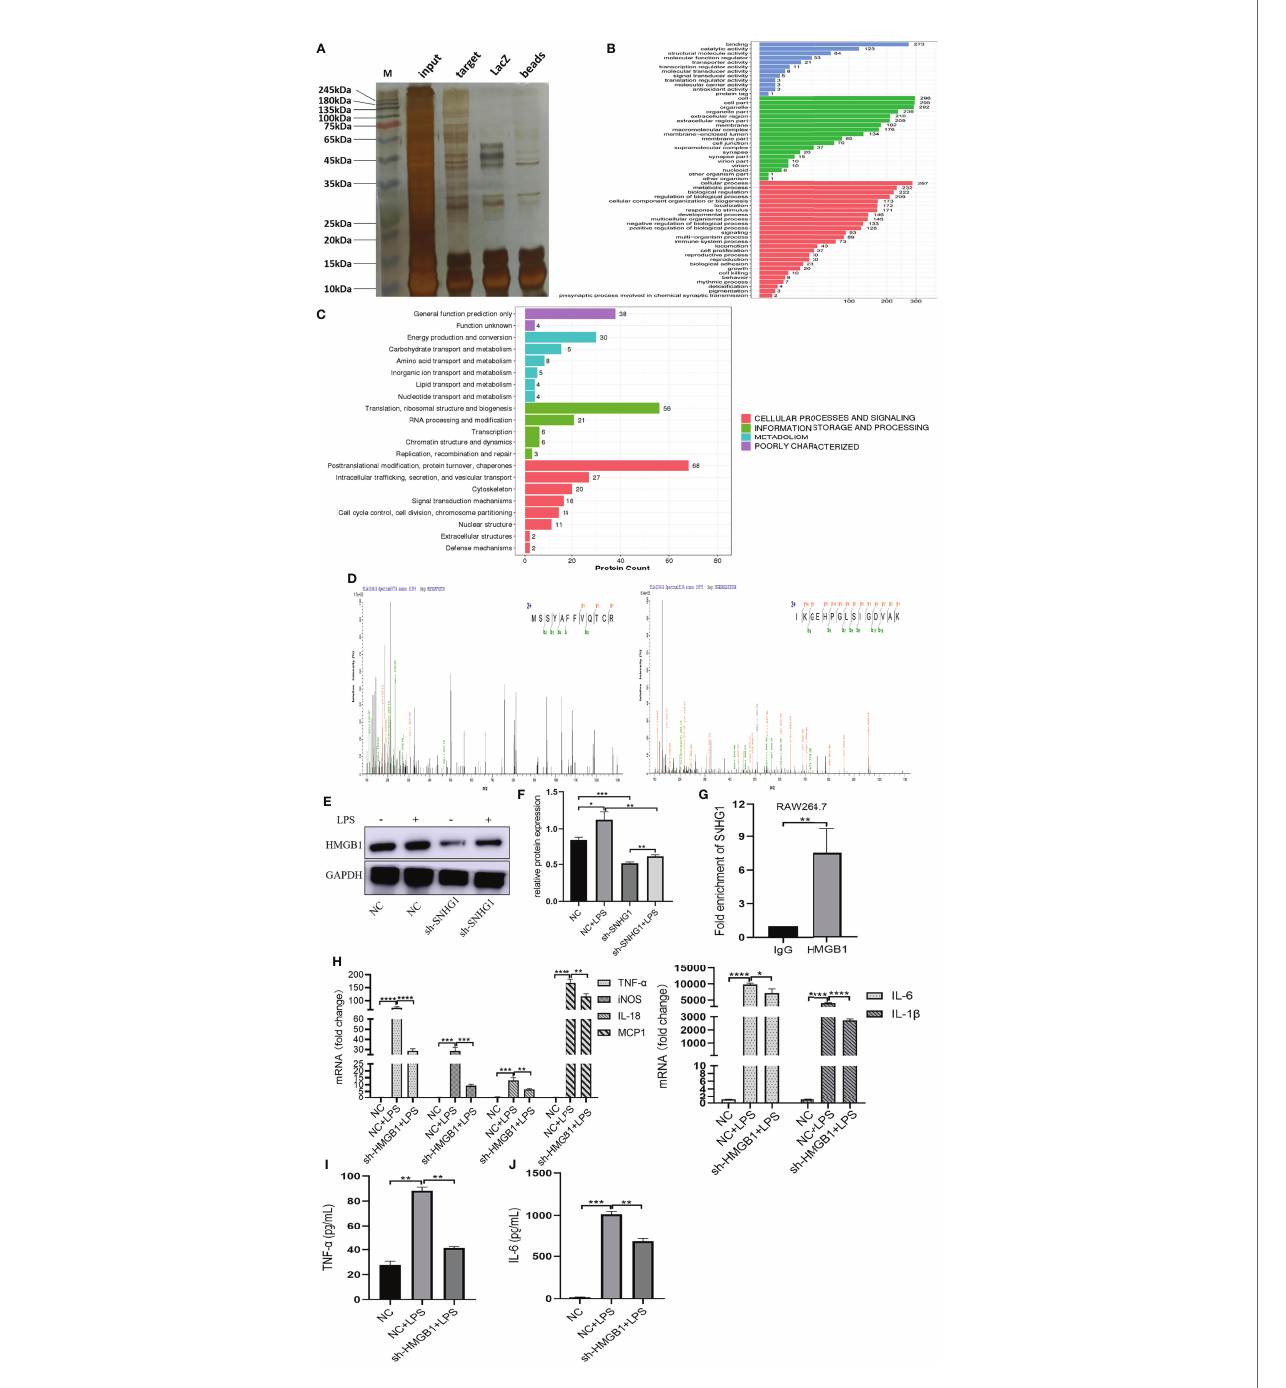
FIGURE 4 | SNHG1 interacts with HMGB1 in RAW264.7 cells. (A) The results of the silver staining assay showed the SNHG1 binding protein. (B) GO function analysis of differentially expressed proteins that bind SNHG1. (C) KEGG pathway analysis of differentially expressed proteins that bind SNHG1. (D) Two HMGB1 peptides were detected in the mass spectrometry results. (E, F) The expression of HMGB1 in RAW264.7 cells treated with LPS, as determined by Western blot. (G) Anti-HMGB1 RIP assay was executed in RAW264.7 cells, followed by qRT-PCR. (H) Expression of proin fl ammatory cytokines (TNF- a , iNOS, IL-18, MCP-1, IL-6 and IL-1 b ) in RAW264.7 cells transfected with lentivirus sh-HMGB1 treated with LPS, as determined by qRT-PCR. (I, J) Expression of proin fl ammatory cytokines (TNF- a , IL-6) in RAW264.7 cells transfected with lentivirus sh-HMGB1 treated with LPS, as determined by ELISA. Data are indicated as the mean ± SD, * P <0.05, ** P <0.01, *** P <0.001, **** P